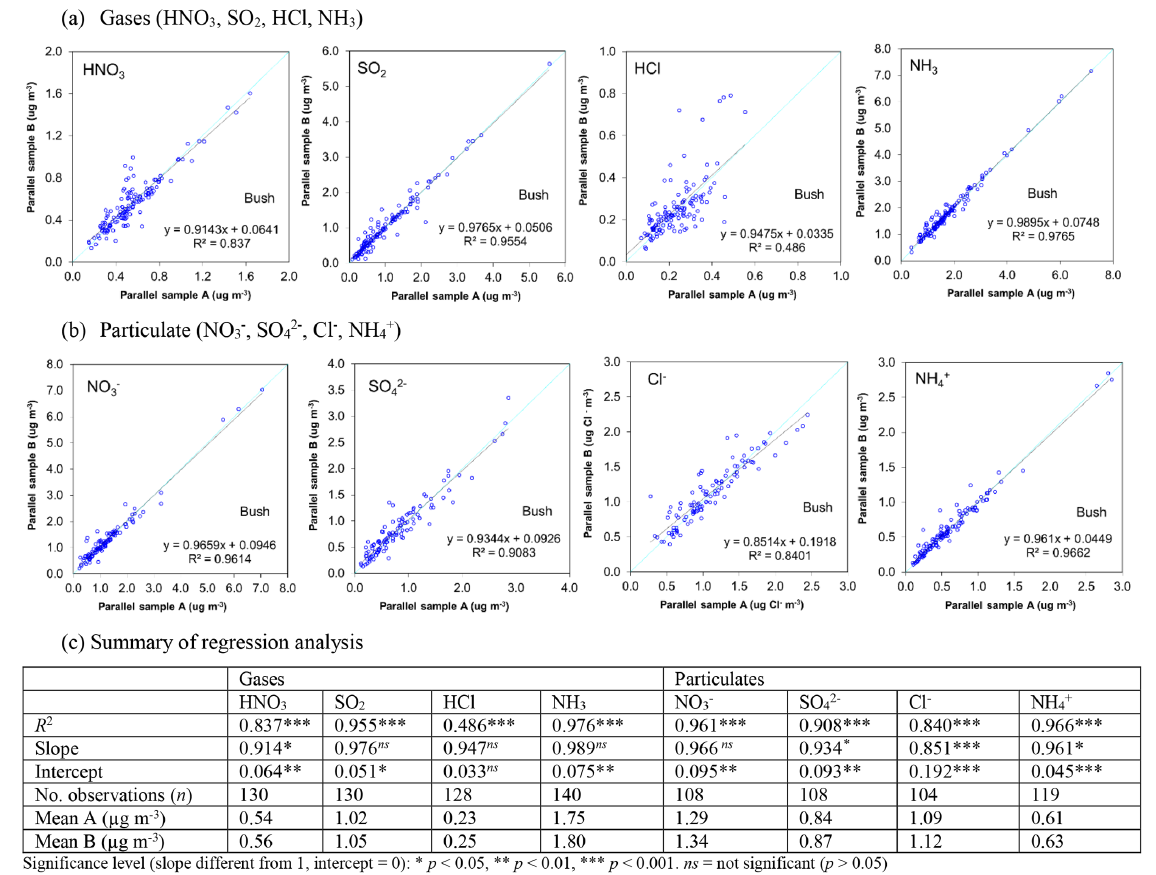
Figure 2. Comparisons of parallel measurement of monthly (a) atmospheric reactive gases (HNO 3 , SO 2 , HCl, and NH 3 ) and (b) particulate (NO − , SO 2 − , Cl − , and NH + ) concentrations from duplicate DELTA sampling at the UK Acid Gas and Aerosol Monitoring Network 3 4 4 (AGANet) and National Ammonia Monitoring Network (NAMN) site Bush OTC (UKA00128) in southern Scotland for the period 1999 to 2015. (c) A summary of the regression analyses. Each point represents a comparison between the paired monthly DELTA